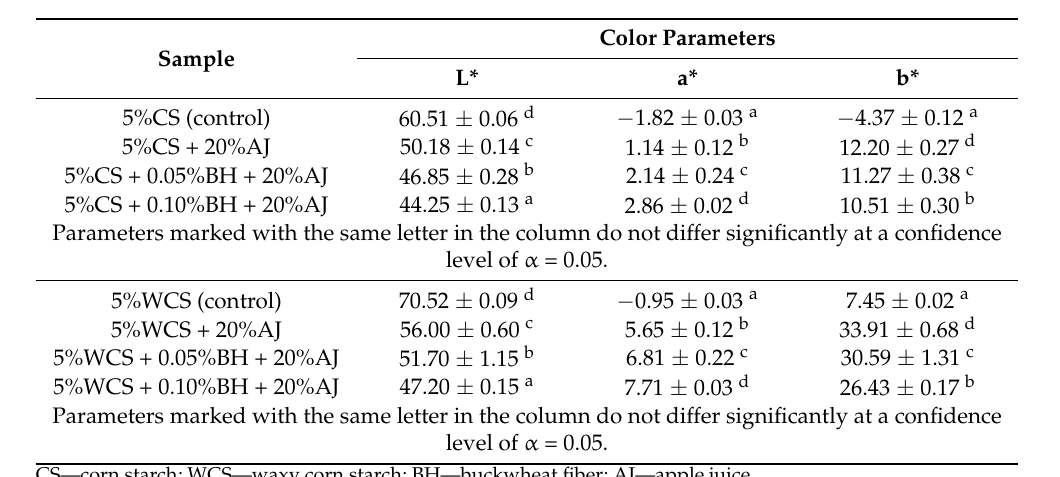
Table 7. Color parameters (L*, a*, and b*) of samples with normal and waxy corn starch, buckwheat fiber and